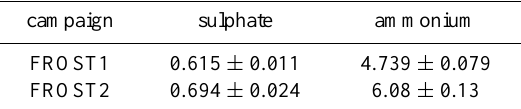
Table A1. Relative ionisation efficiencies (RIE) for the species sul- phate and ammonium for the FROST1 and FROST2